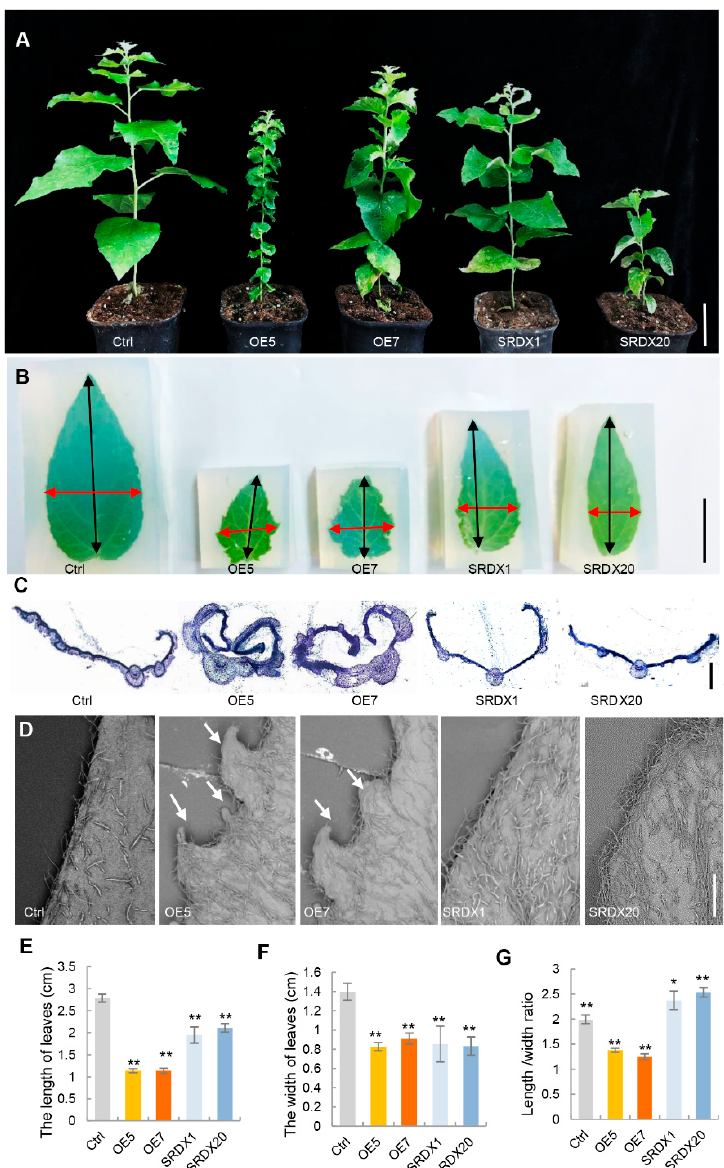
Figure 2. Morphological comparisons of PagKNAT2/6b transgenic and non-transgenic control poplar. ( A ) Phenotypes of the seedlings of non-transgenic control poplar (Ctrl), 35S:PagKNAT2/6b over- expression lines (OE5 and OE7), and PagKNAT2/6b -SRDX dominant repression lines (SRDX1 and SRDX20). Bars = 6 cm. ( B ) Phenotypes of LPI3 leaves of Ctrl and PagKNAT2/6b transgenic plants,